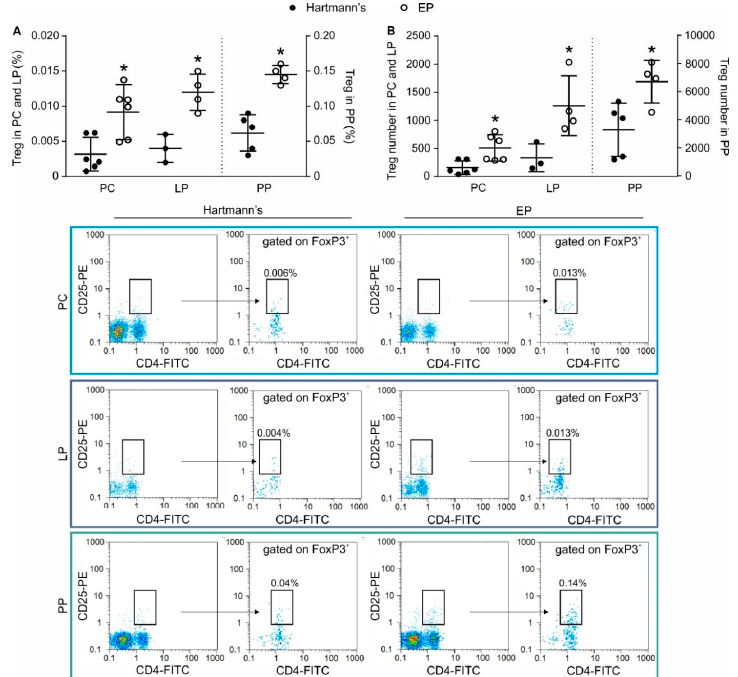
Figure 5. In Vivo EP influence on Treg numbers in the peritoneum and the gut immune system. EP was applied either by intraperitoneal injections or through the oral route to healthy C57BL/6 mice and ( A ) the proportion and ( B ) the number of Treg (CD4 + CD25 high FoxP3 + ) was determined ex vivo from the cell suspensions of peritoneal cells (PC), Peyer’s patches (PP), or lamina propria cells (LP). Representative dot plots and gating strategy are shown below the graph. * p < 0.05 represents the significant difference between EP-treated mice compared to vehicle-treated mice. Molecules 2020 , 25 , x FOR PEER REVIEW